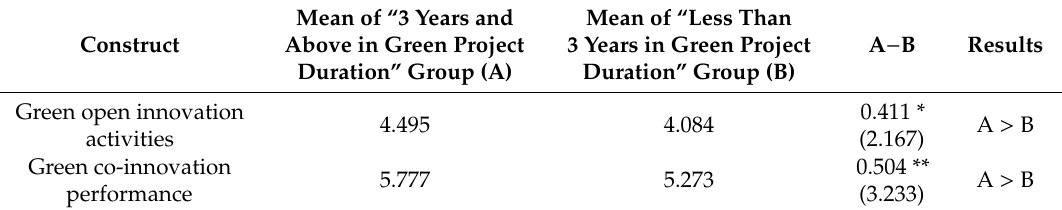
Table 8. Di ff erences between groups with various green project